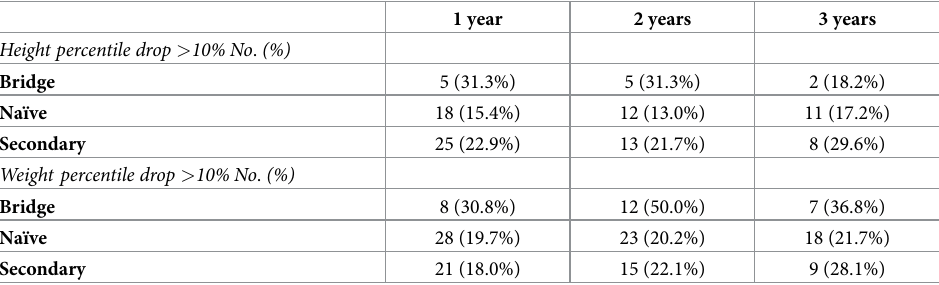
Table 4. Proportion of height and weight percentile drop > 10% from baseline by